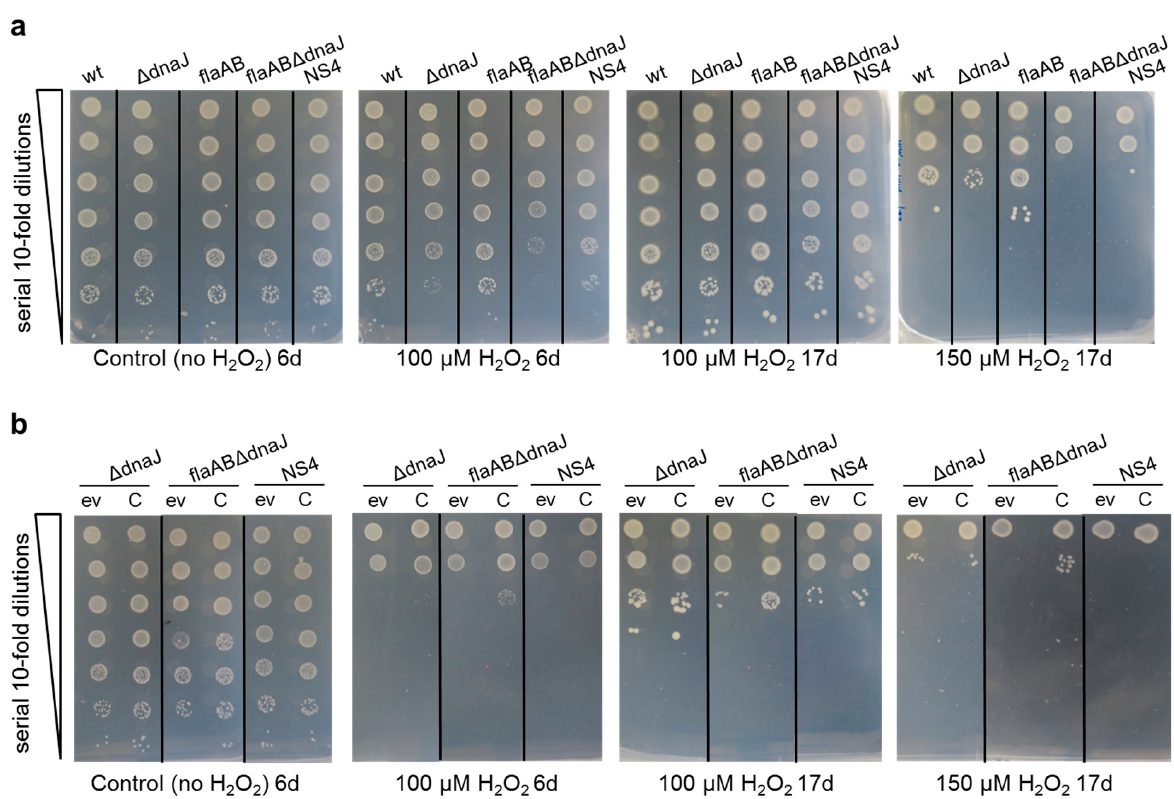
Figure 6. DnaJ loss-of-function in S. meliloti leads to increased sensitivity against oxidative stress. ( a ) Oxidative stress tolerance of GR4 (wt) and its dnaJ deletion mutant ( ∆ dnaJ), the flagellaless GR4flaAB (flaAB) and its dnaJ deletion (flaAB ∆ dnaJ), and Tn 5 insertion (NS4) mutants. ( b ) Oxidative stress tolerance of dnaJ mutants carrying the empty vector (ev) or the dnaJ -expressing plasmid construct (C). Cell suspensions in MM were prepared from mid-log cultures at the same OD 600 , and 10 µL of 10-fold serial dilutions were spotted on MM agar plates supplemented or not with different concentrations of H 2 O 2 . Plates were incubated at 28 °C for 6 (6 d) or 17 days (17 d).